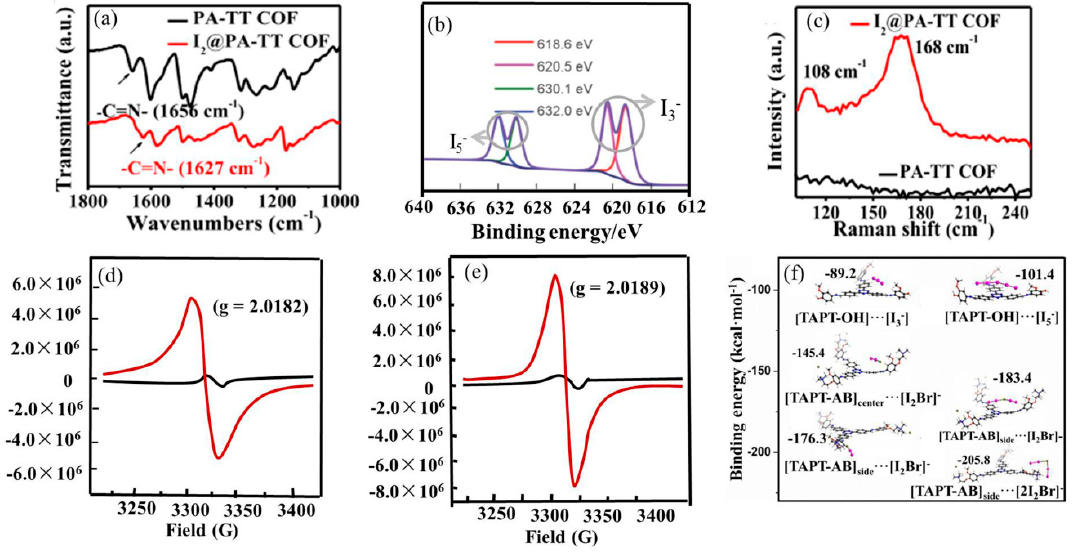
Figure 1. ( a ) FT-IR spectra of PA-TT COF and I 2 @PA-TT COF. Reprinted/adapted with permission from Ref. [48]. Copyright (2023), Elsevier. ( b ) Iodine high-resolution XPS spectra of I 2 @TTF-TD-COF. Reprinted/adapted with permission from Ref. [49]. Copyright (2022), Springer-Verlag